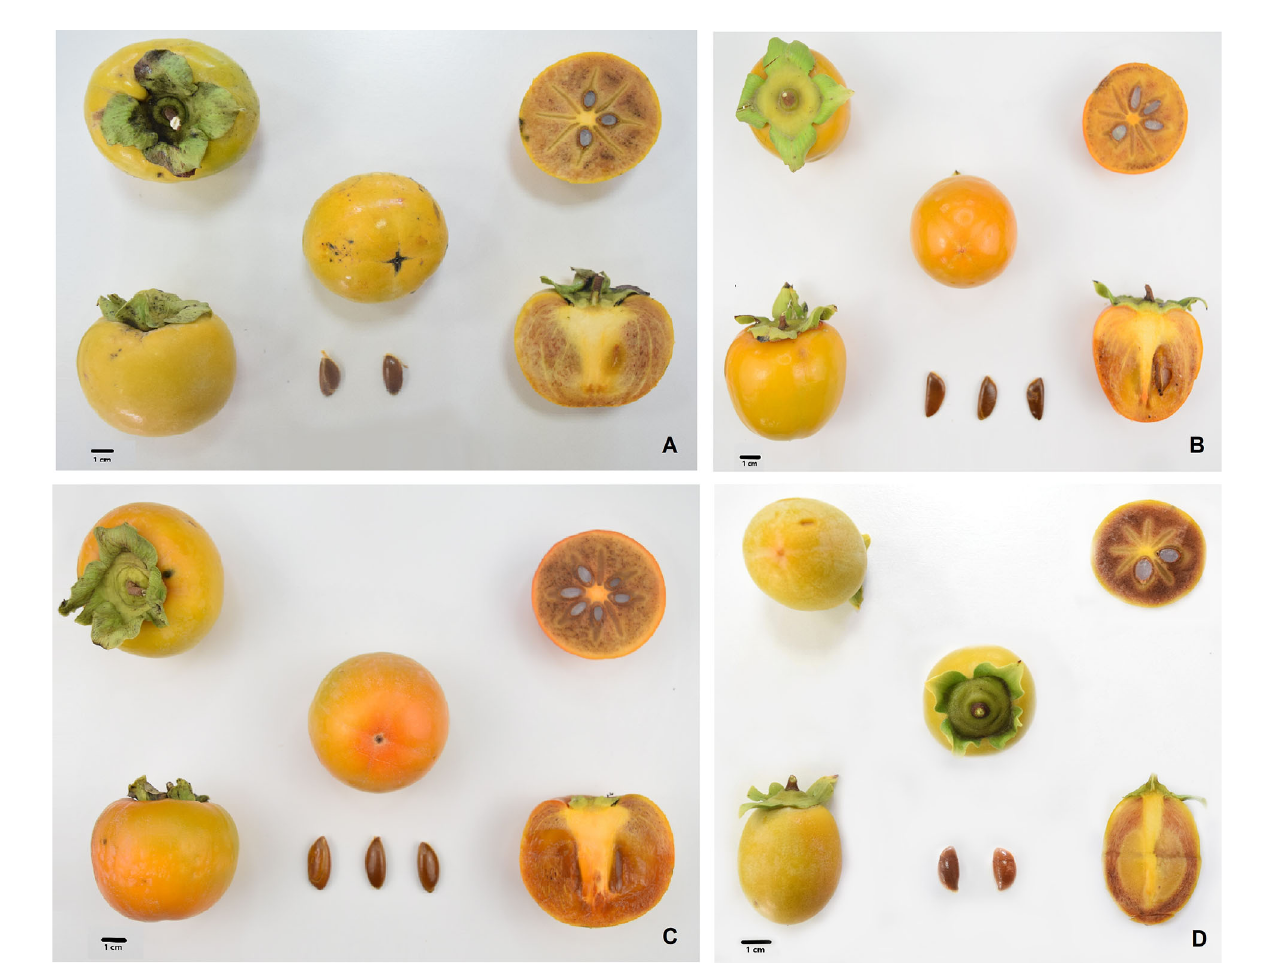
FIGURE 1 Morphological characteristics of persimmon fruits of Kaki tipo, Cioccolatino, Vaniglia and Lampadina cultivars. (A) Kaki tipo; (B) Cioccolatino; (C) Vaniglia; (D) Lampadina. Bars correspond to a 1